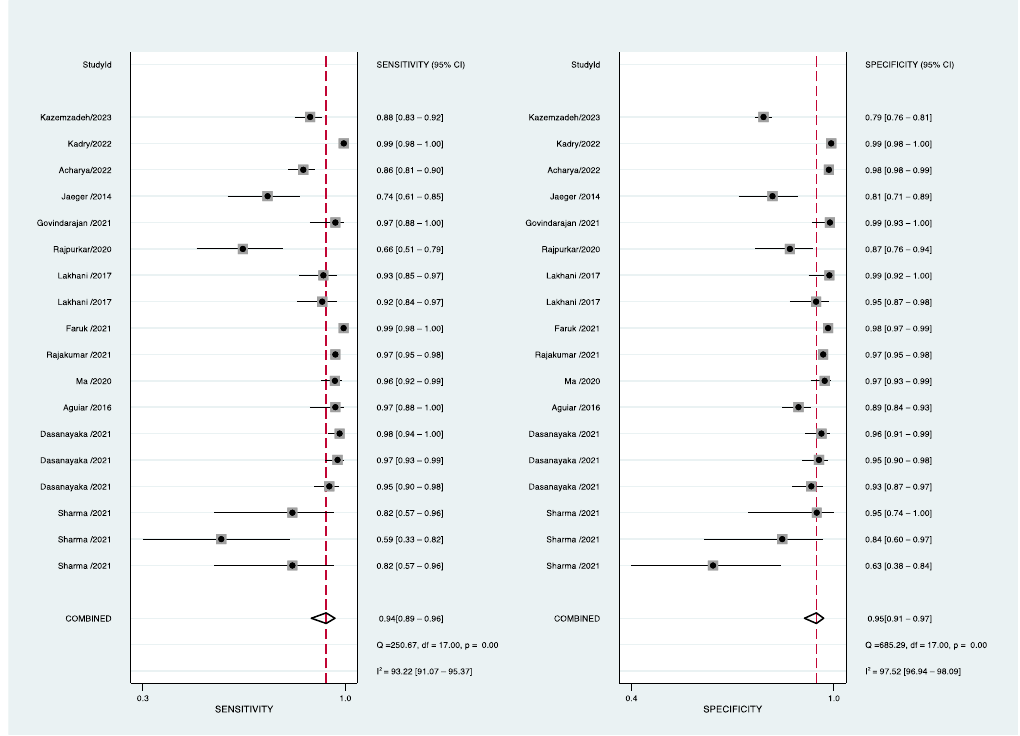
Figure 4. Forest plot of development-study sensitivity and specificity for PTB [38,42,43,47,51,54,63,64,66 – 70].